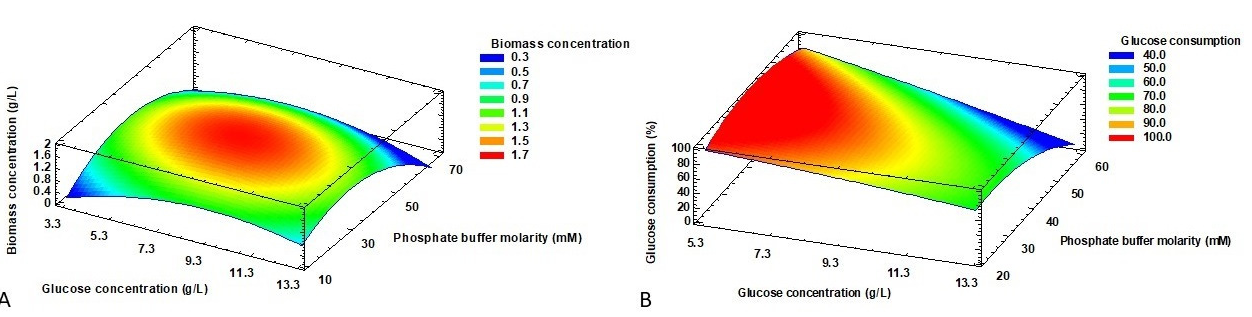
Table 2. Regression coefficients of the predicted second order polynomial models for biomass con- centration and glucose consumption. Effect